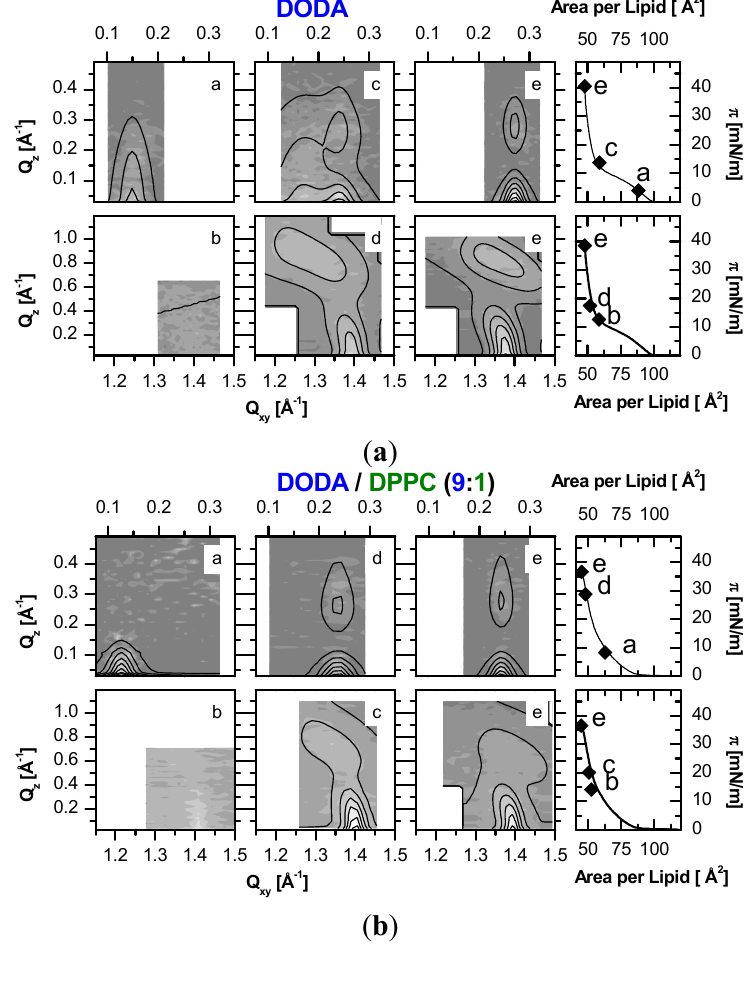
Figure 3. Small and wide angle Grazing Incidence X-ray Diffraction (GID) measurements along DODA DPPC isotherms at the molecular areas indicated (0.01 mmol/L PSS in y 1 − y monomer units and T = 20 °C). The low-angle diffraction peaks are due to aligned PSS chains, the wide-angle peaks measure the lipid structure. ( a ) pure DODA ( M ( b ) DODA DPPC ( M (PSS) = 76 kDa). ( c ) DODA 0.9 0.1 w the small angle peaks, background is subtracted. Contour plots are calculated from least square fits to appropriate